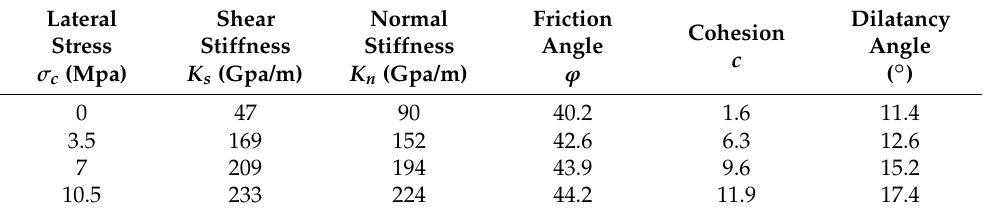
Table 8. Equivalent parameters of rock fracture under different lateral